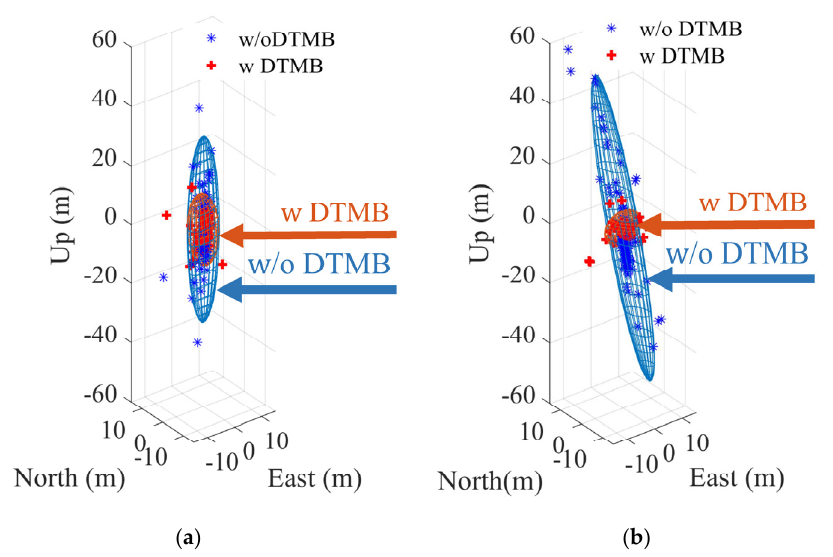
Figure 21. Positioning error and corresponding 95th percentile uncertainty ellipsoid in ENU frame. ( a ) Clockwise. ( b ) Counter-clockwise. ( a ) Clockwise. ( b )